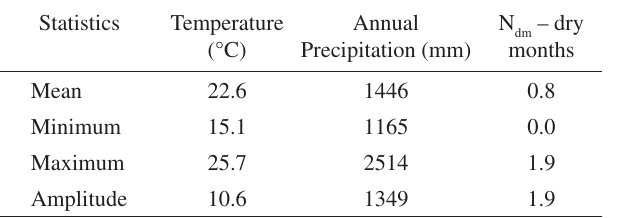
Table 2. Statistics of the climatic data.